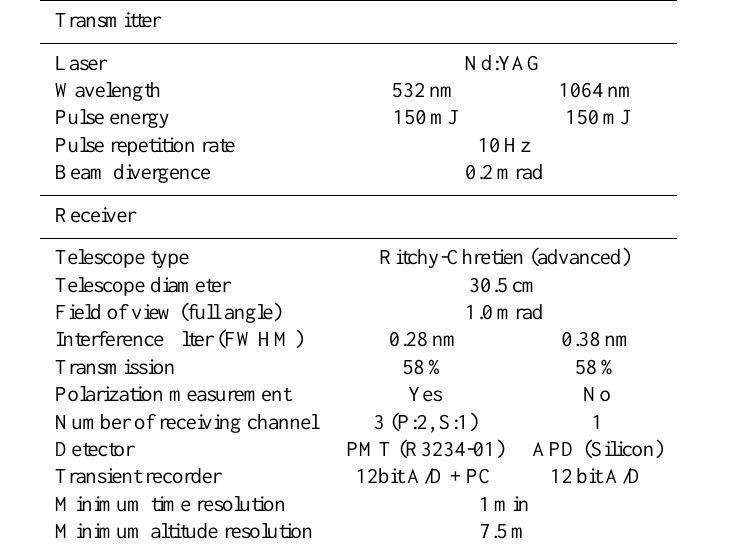
Table 3. Characteristics of the two-wavelength polarization